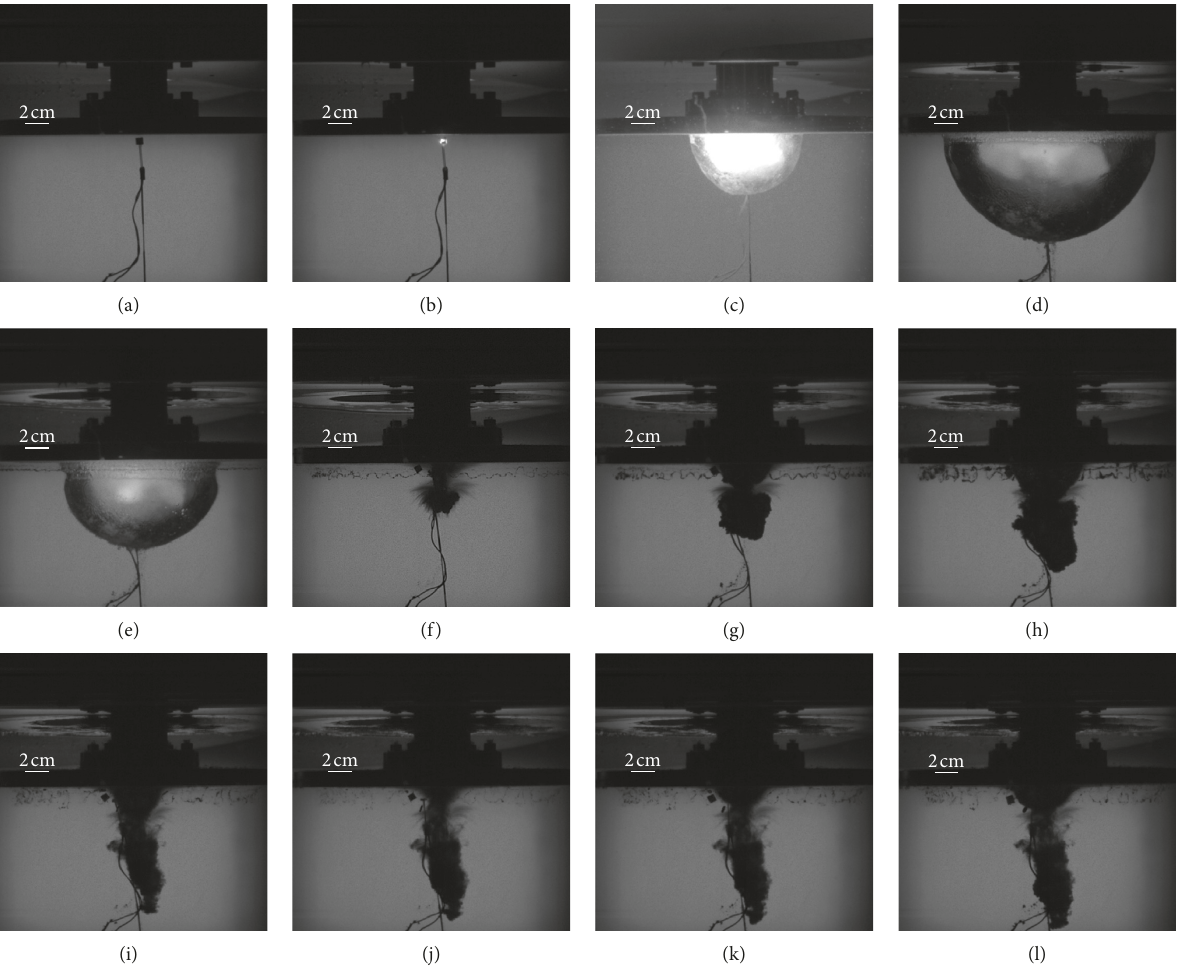
Figure 12: Evolution of the first two cycles of the underwater explosion bubble’s expansion and collapse below the target plate with 5 mm stand-off. (a) t � 0.0000ms. (b) t � 1.7245ms. (c) t � 6.6245ms. (d) t � 8.7245ms. (e) t � 13.4495 ms. (f) t � 16.2295 ms. (g) t � 17.2745 ms. (h) t � 19.4495ms. (i) t � 21.9745ms. (j) t � 26.6995 ms. (k) t � 23.2745 ms. (l) t � 24.4745